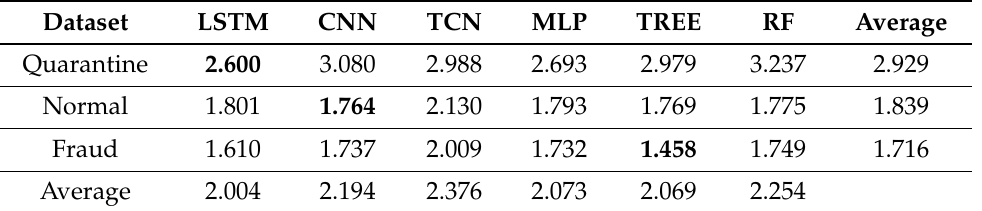
Table 11. MASE results for each period and each model. The results have been obtained after choosing the best set of parameters for each case by carrying out a parameter optimization process. The last row and column correspond to the means for each model and dataset, respectively. The best model for each dataset is specified in